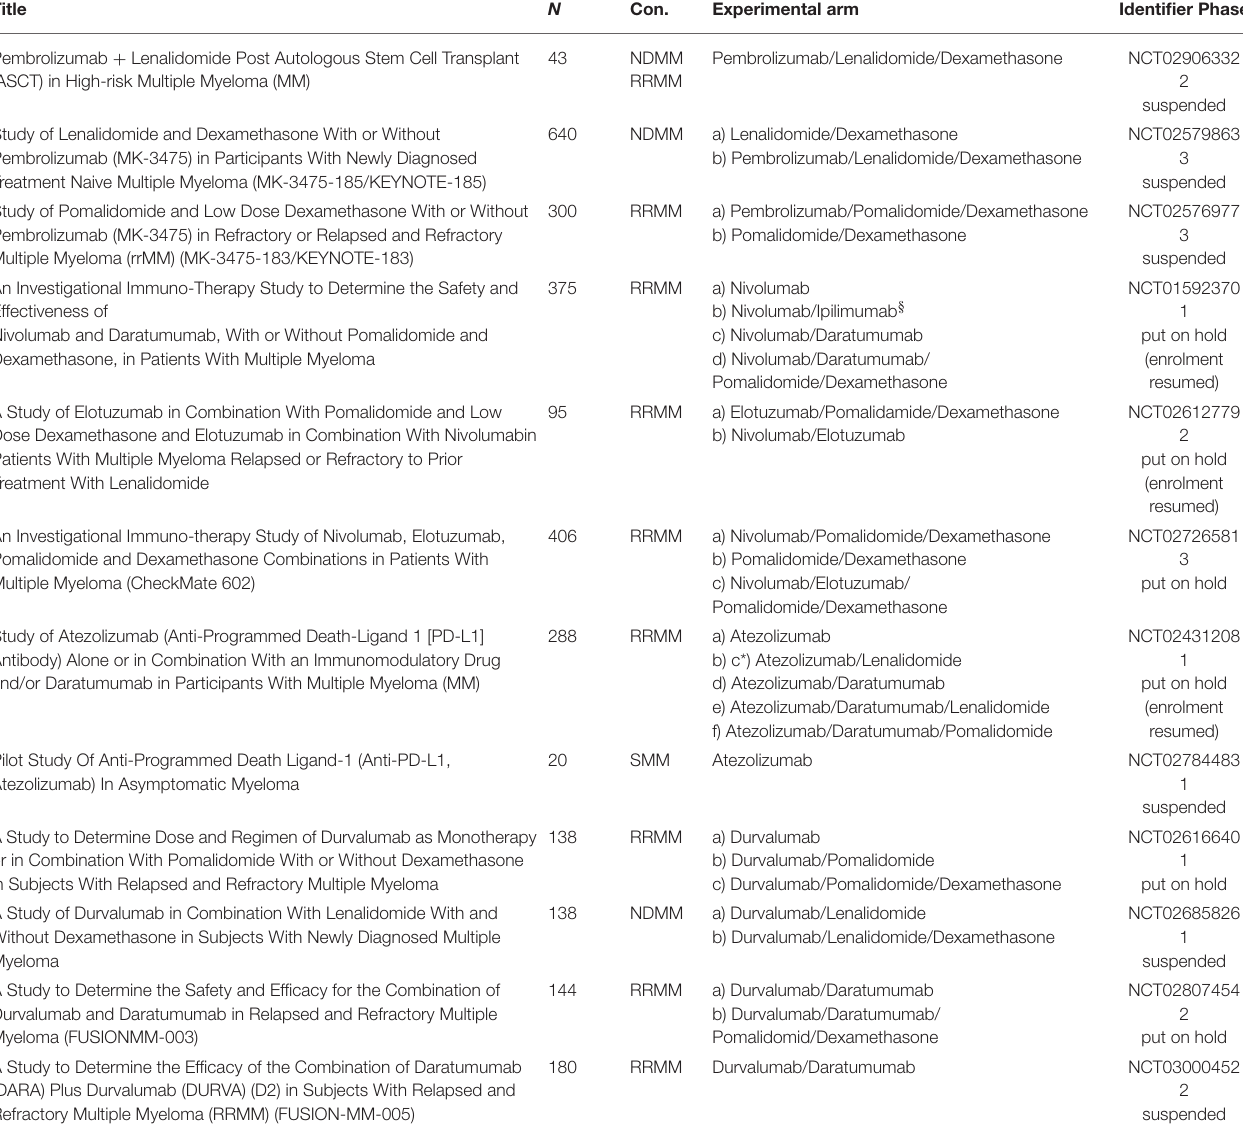
N Con. Experimental